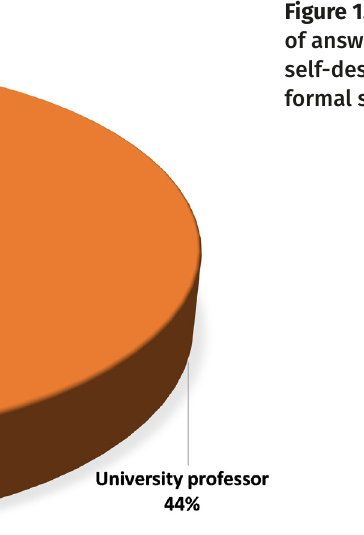
Figure 1. Grouping of answers for self-designation in formal